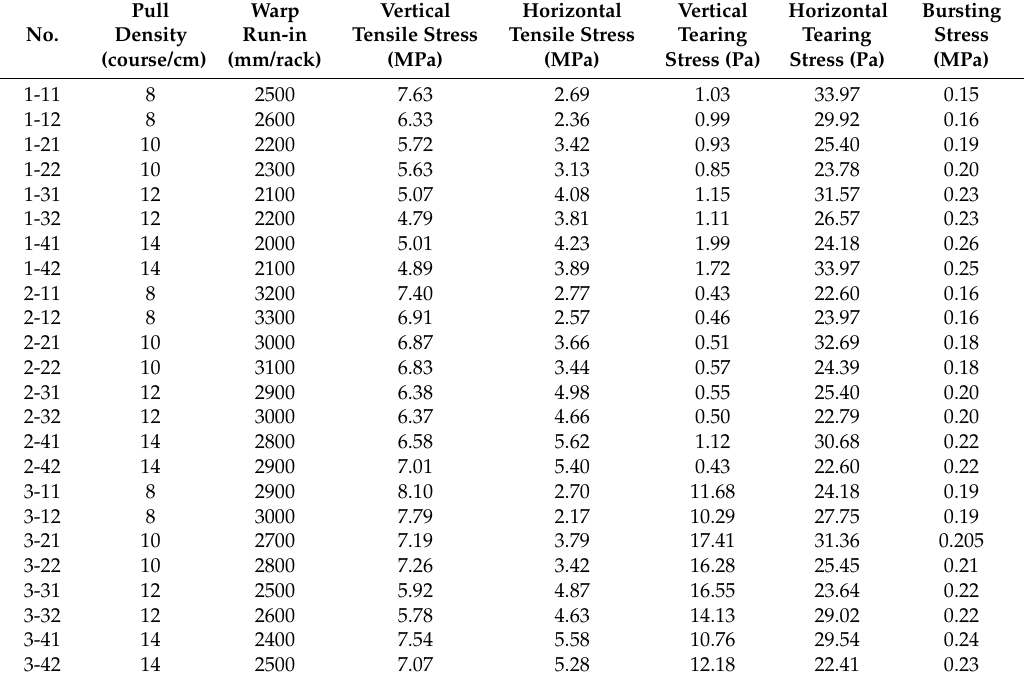
Table 2. The test results of all